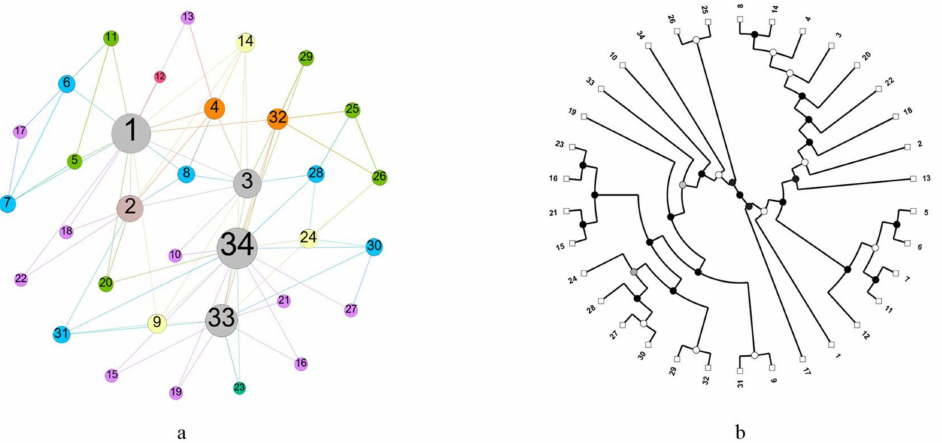
Figure 1. A real network and its corresponding hierarchical random graphs. ( a ) A network visualiza- tion, in which the real name of each vertex is hidden as a number. ( b ) A possible hierarchical random graph model, in which the leaf nodes correspond to the vertices of the real network, and the color depth of each non-leaf node represents the connection possibility between the leaf